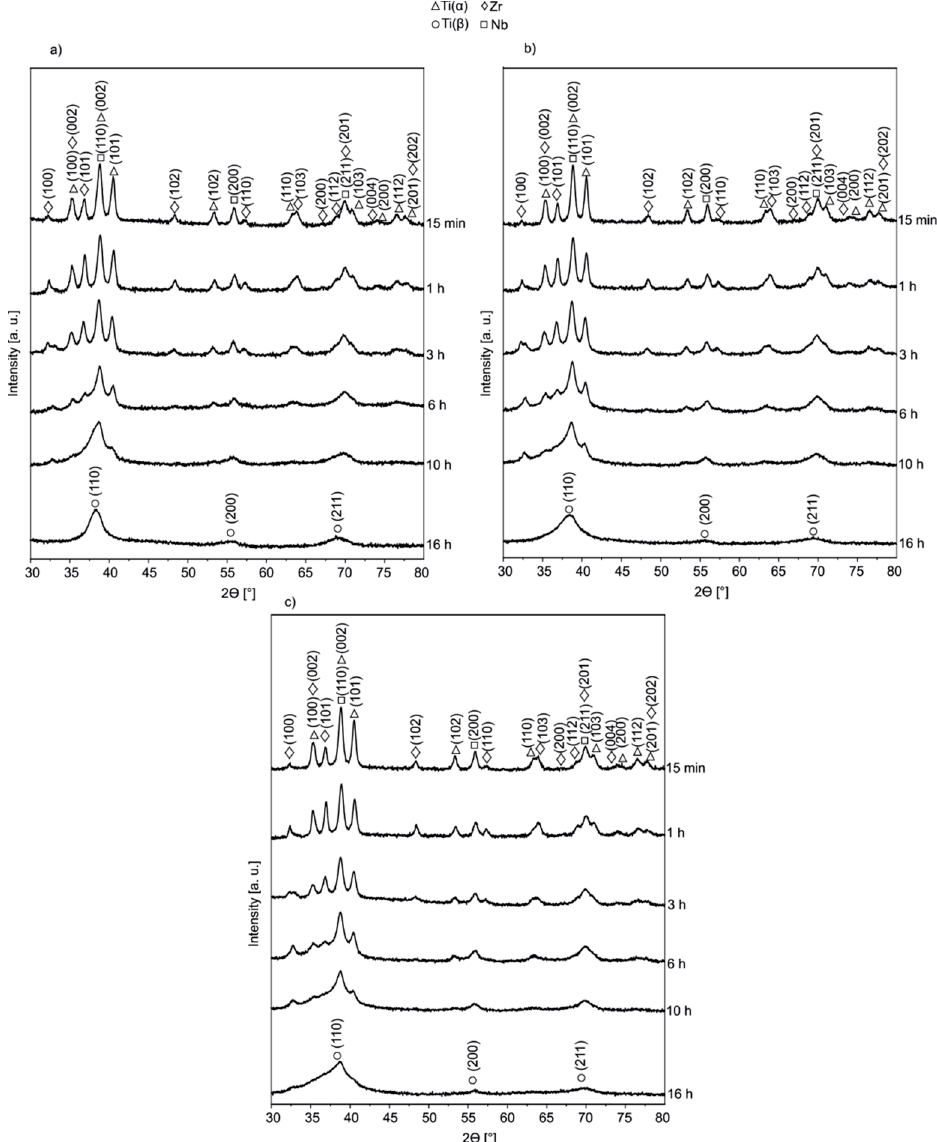
Figure 2. XRD spectra of Ti23Zr25Nb-based composites powders with ( a ) 3 wt.%, ( b ) 6 wt.%, and ( c ) 9 wt.% 45S5 Bioglass content mechanically alloyed over different times.